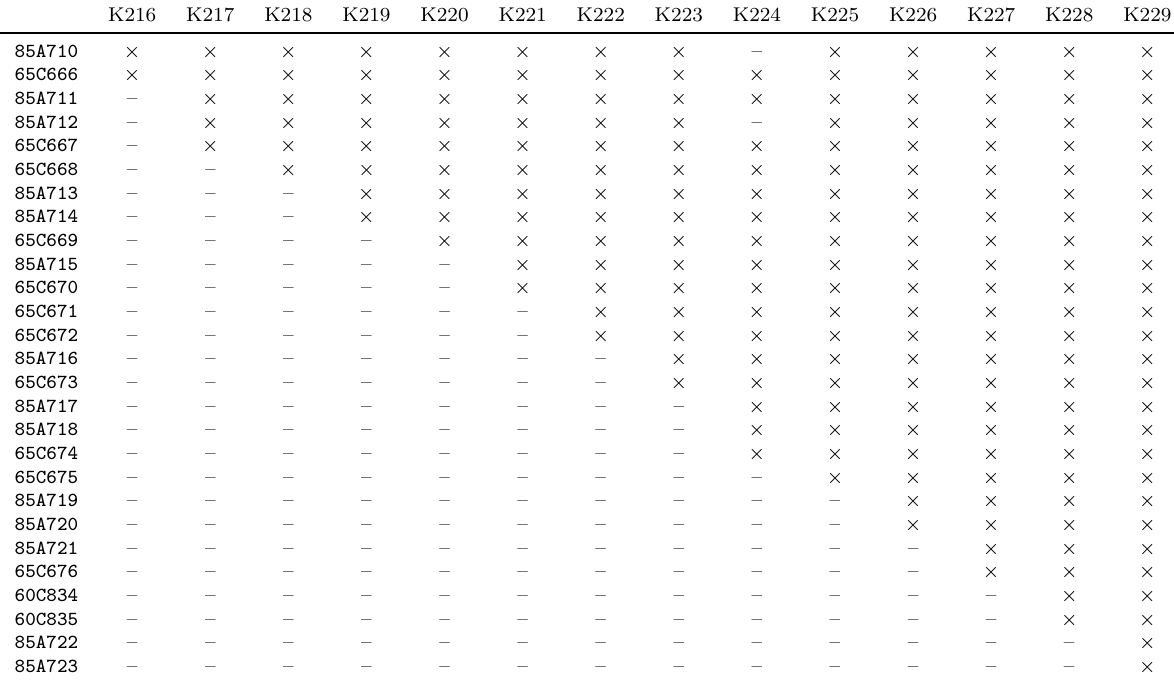
Table 2. The presence of initially fresh fuel assemblies throughout considered cycles K216–K229 ( × in the cycle, – not in the cycle).